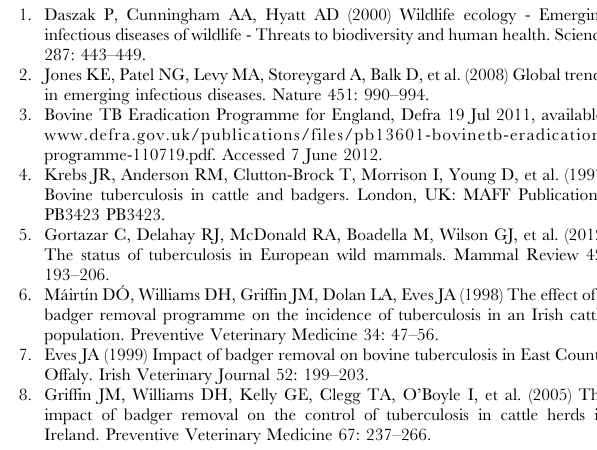
Figure S1 Configuration of badger social group territo- ries between 2006 and 2009. Allocation of vaccine treatment (shaded areas) and control (open areas) is shown. Circles indicate additional main setts located after bait marking of that year and for which the territorial boundaries could not be delineated until the following year, but which were determined to represent discrete social groups and allocated a treatment accordingly. New groups were recruited in some years and a minority of groups merged together to form a ‘‘super-group’’ and/or split apart to form two smaller groups over the course of the study. Additional badger groups may have been present in non-surveyed areas adjacent to the mapped territories, particularly around the edge of the study area. Table S1 Number of badgers captured at each succes- sive capture event during the four-year field study, together with approximate capture dates. Table S2 Estimated sensitivities and specificities for each diagnostic test and test combinations used in the analyses. Table S3 Covariates included in the investigation of the direct D and indirect I effects of BCG vaccination.